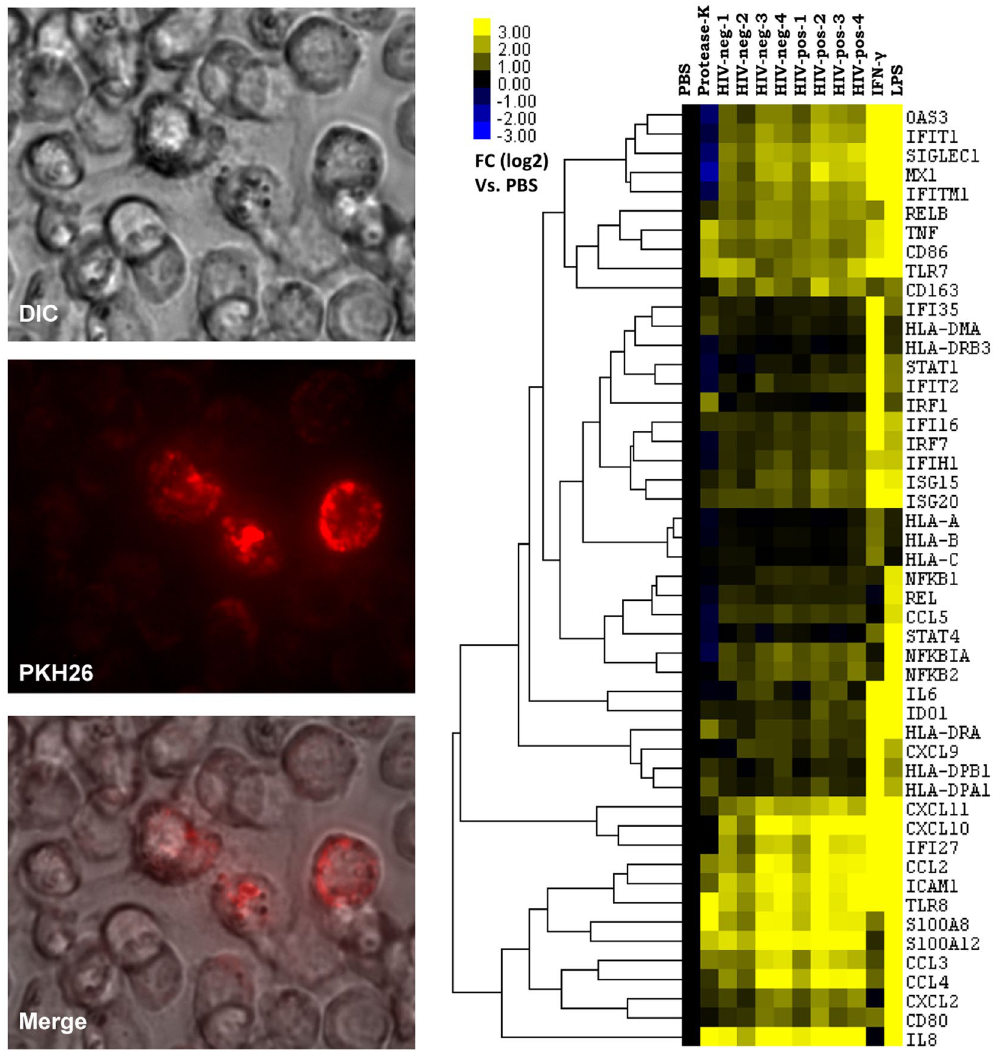
Figure 7. Plasma exosomes from HIV-positive subjects induce gene expression changes indicative of immunomodulatory effects and immune activation in THP-1 monocytic cells. THP-1 cells were treated with 20 μ g PKH26-labeled plasma exosomes for 72 hrs (left panel). THP-1 cells were treated with immunoaffinity purified-plasma exosomes (20 μ g) from 4 HIV-positive and 4 HIV-negative subjects for 72 hrs (lanes 3 to 10) or with IFN- γ (100 IU/ml) or LPS (0.5 μ g/ml) for 24 hrs (lanes 11 and 12). Gene expression was measured using the Nanostring nCounter PanCancer Immune Profiling Panel. Heatmap shows unsupervised hierarchical clustering of expression changes in 49 genes associated with interferon response, cytokines/chemokines, immune activation, innate immune response, and inflammation following treatment with exosomes relative to controls (lanes 1 and 2). Treatment of THP-1 cells with HIV-positive and HIV-negative plasma exosomes induced gene expression changes partially overlapping those induced by IFN- γ and LPS. Representative of 2 independent